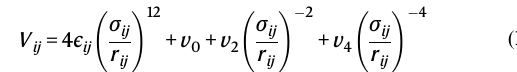
stable fi xed point at X rel ≈ 1.5064 ξ (inset), veri fi ed in the the numerical simulations asa fl atteningof X rel as t approaches t * . D – F Twoactiveparticlesmovingalongthe x - axiswithseparationvectorsperpendiculartothedirectionof motion(restsameas above). D Time dependence of y -positions of the active particles showing con- vergent trajectories. E The x-component of centre of mass velocity is positive and constant, solid line isthe prediction from theory. Inset shows y-component centre of mass velocity iszero, indicating symmetric approach. F The twoactive particles approach each other in fi nite time t * . The solid line, a prediction from theory, suggests that the relative position has a scaling form Y rel ∝ ∣ t − t * ∣ α , where α =1/2 as t → t * . The data presented here are averaged over 256 independent simulations and the errorbars, denoting the standard deviations, are estimated from this